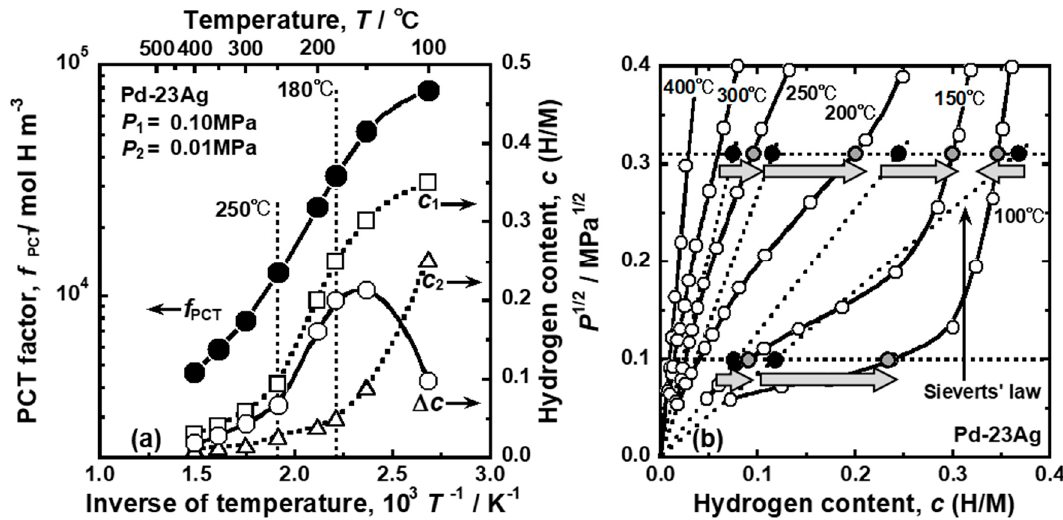
Figure 12. ( a ) Temperature dependence of the PCT factor ( f PCT ), the hydrogen concentration at each feed and permeation side of the membrane ( c 1 and c 2 ), and their di ff erence ( ∆ c ) when the pressure condition of the feed and permeation sides are fixed to be 0.10 and 0.01 MPa, respectively [27]. ( b ) PCT curves of Pd-23 mol%Ag alloy at low pressure range [27], with copyright permission from Japan Institute of Metal and Materials (JIM).